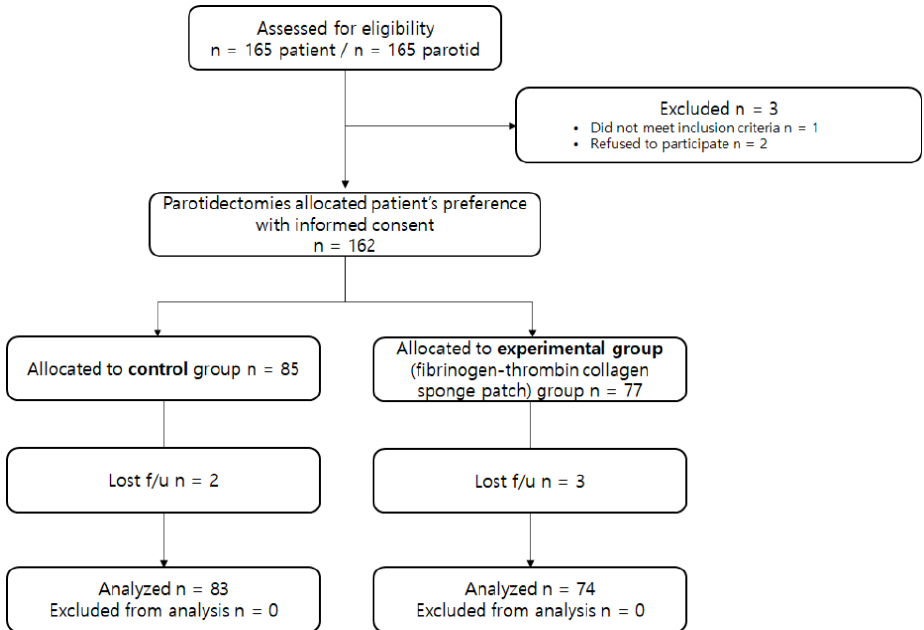
Figure 1. The study flow chart in line with the CONSORT statement (http://www.consort-statement.org; accessed on 5 October 2020). Numbers of participants included in this study are represented in the diagram.